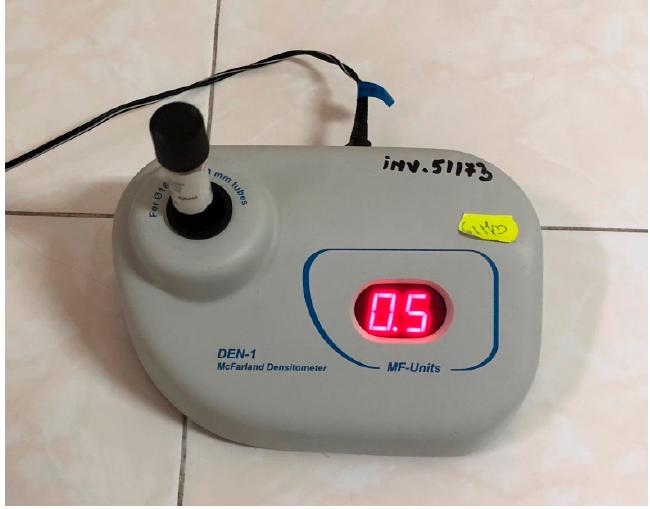
Figure 1. The ATCC 25175 suspension of S. mutans prepared at 0.5 McFarland units with the densitometer device (DEN-1 McFarland Densitometer, Biosan, BS-050102-AAF,